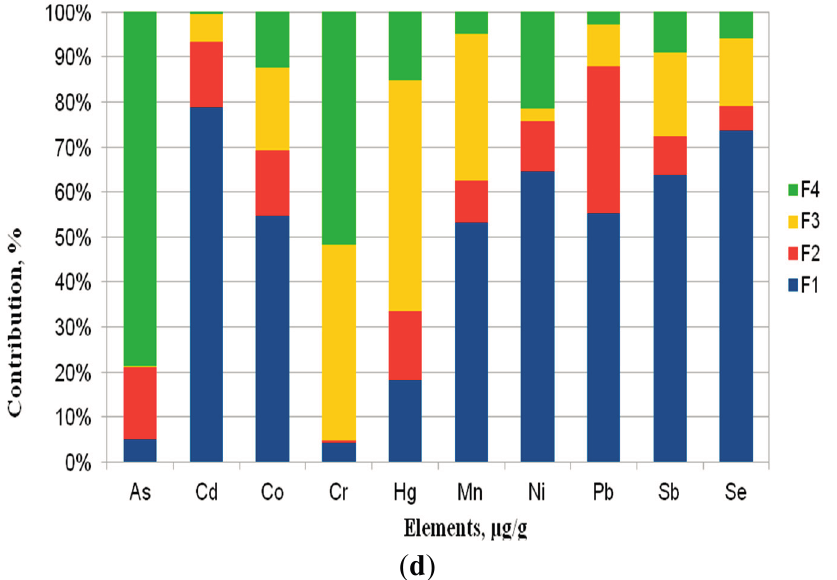
Figure 3. Chemical form distribution of trace elements as a percentage of the